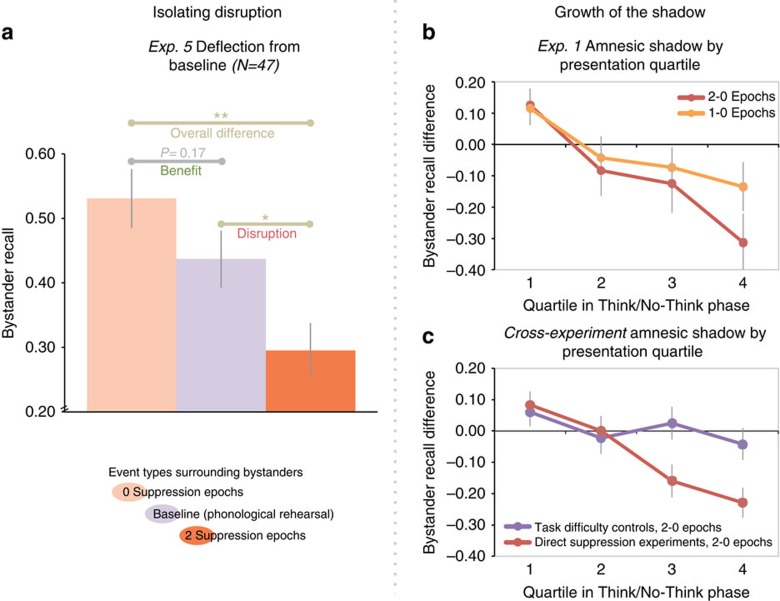
Nature and growth of the amnesic shadow.(a) Cued-recall accuracy in experiment 5 for the zero- and two-dose conditions compared with baseline (purple) with F-tests. Whereas the above-baseline benefit was not significant, below-baseline disruption was. (b) The amnesic shadow (negative deflection of the red line away from the x axis) grew across quartiles, consistent with a practice effect. (c) Unlike the growing shadow apparent across immediate cued-recall studies (red line), thought substitution (experiment 3), Think-Harder (experiment 4) and baseline (experiment 5) studies showed no such growth with practice (purple line). Error bars reflect s.e.m. *P<0.05; **P<0.01.